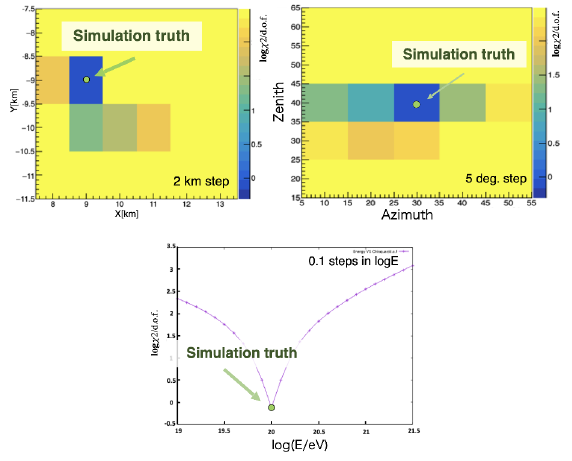
Figure 8. Example of a distribution of (cid:31) 2 of a waveform fitting with 5 parameters.